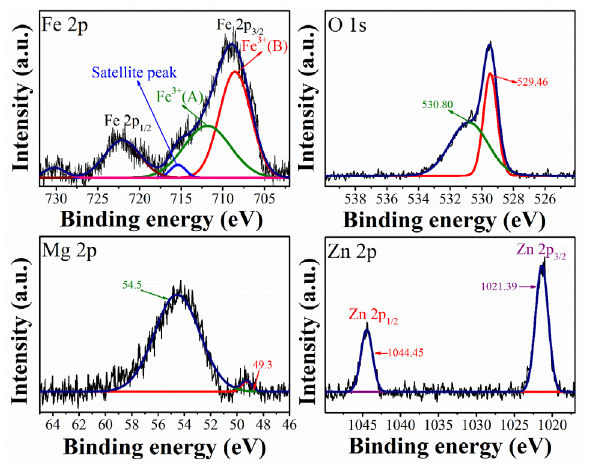
Fig. 7 XPS spectra for Fe 2p, O 1s, Mg 2p, and Zn 2p of Mg 1– x Zn x Fe 2 O 4 ( x = 0.3, 0.4, 0.5, 0.6, and 0.7)